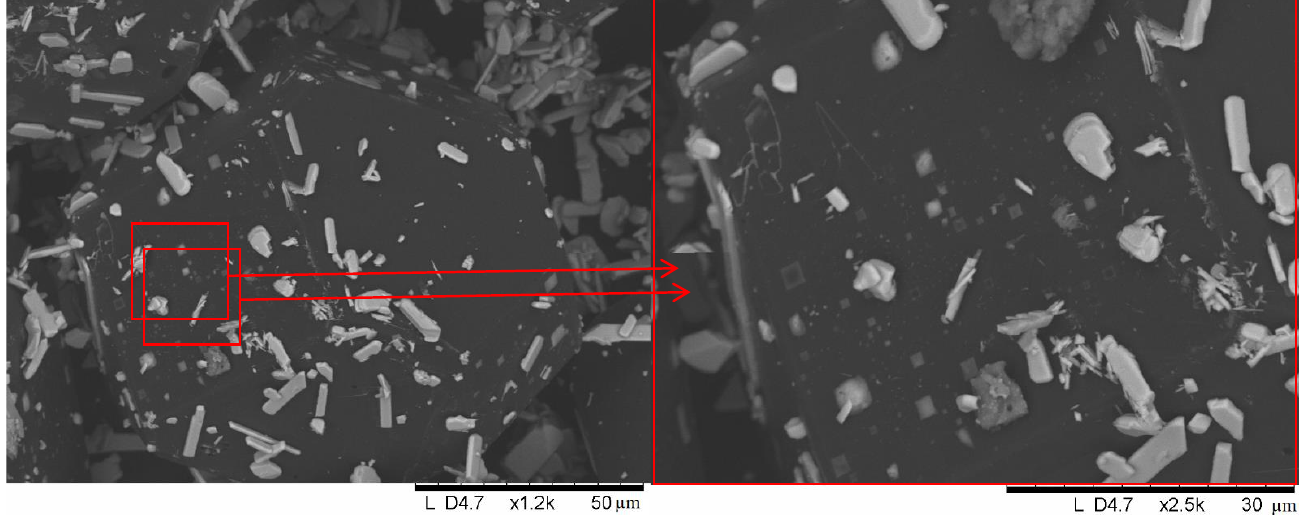
Figure 13. Surface of the diamond crystals with MoO 3 particles, 50-650-60-air, different magnifica- tions.